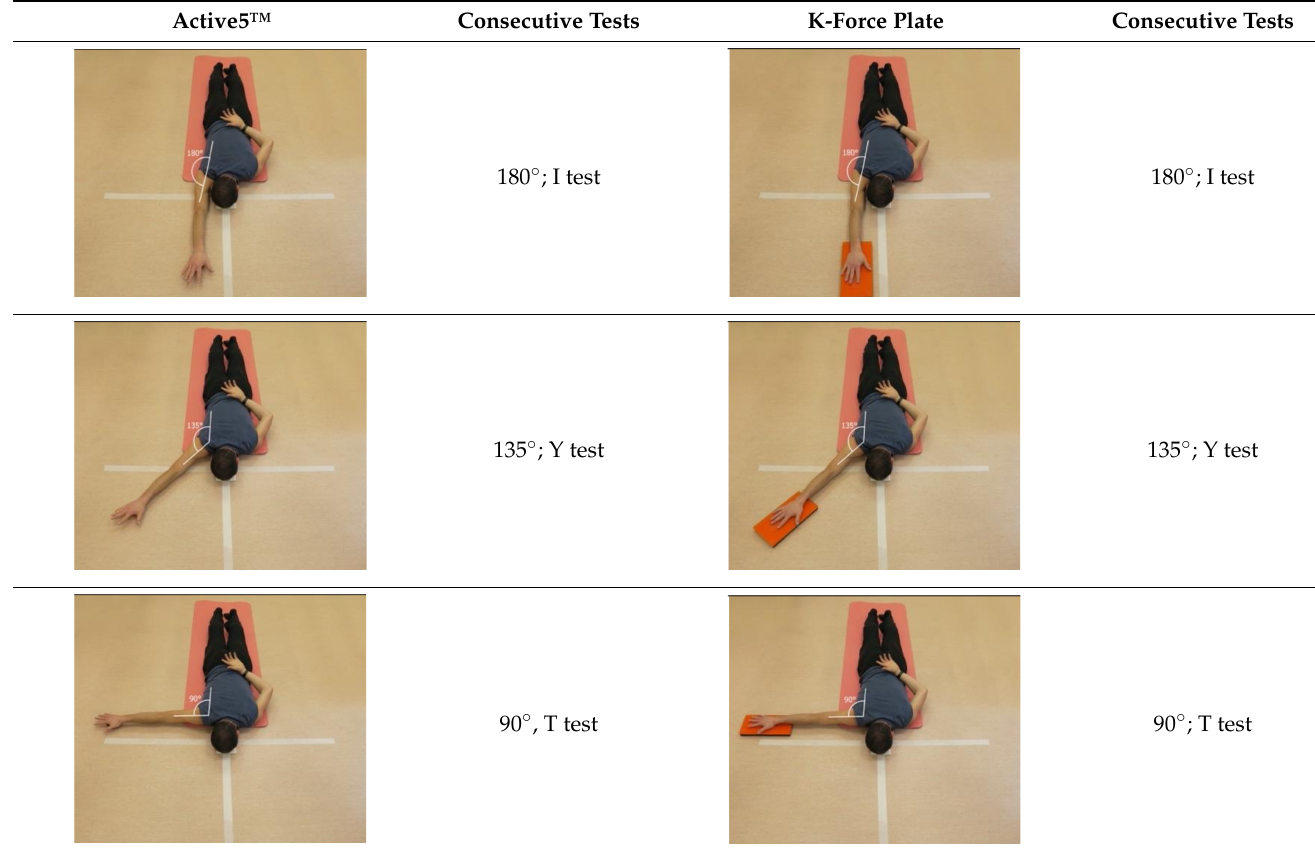
Table 1. Illustration of consecutive tests being